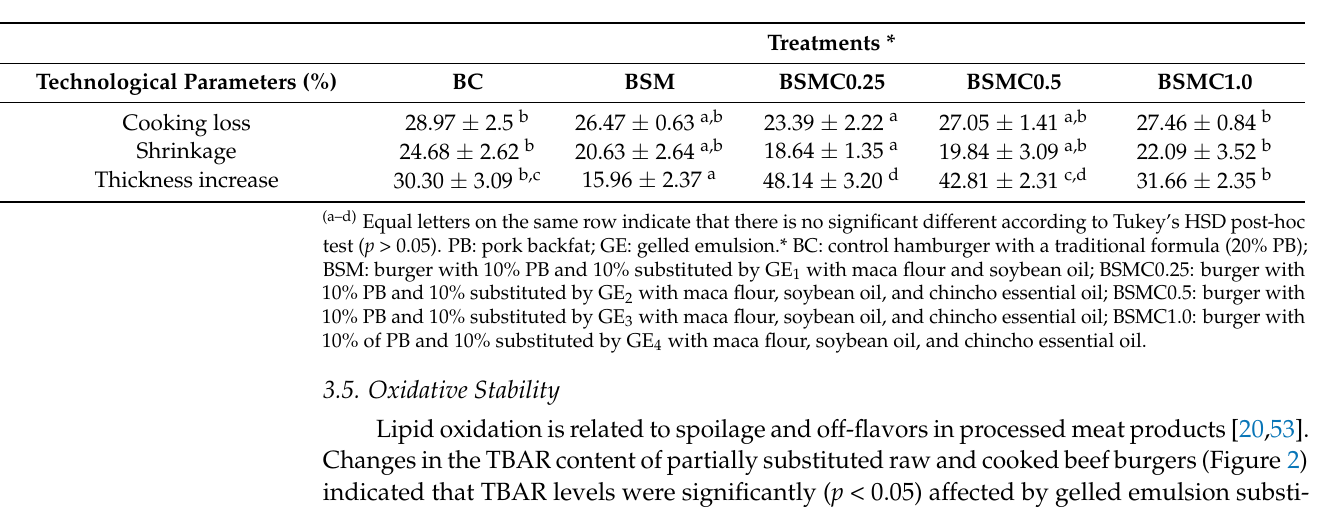
Table 8. Effect of partial replacement of pork backfat with a gelled emulsion of maca flour, soybean oil, and chincho essential oil on the cooking characteristics of beef